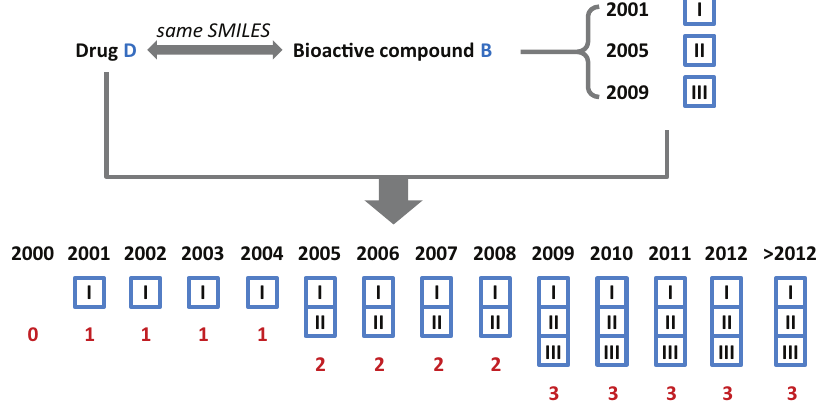
Figure 1. Organization of activity records. The organization of the activity records for a drug over different years is schematically illustrated. Drug D and a bioactive compound B share the same SMILES string (D is mapped to B). The activity records of compound B are extracted from ChEMBL. B is reported to be active against target I in 2001, II in 2005, and III in 2009. These activity records are then assigned to drug D and organized into 14 time intervals (12 of which represent individual years, except 2000 (see text) and >2012). For each interval, a cumulative activity profile is generated for D and recorded. The total number of activity annotations is given in red.